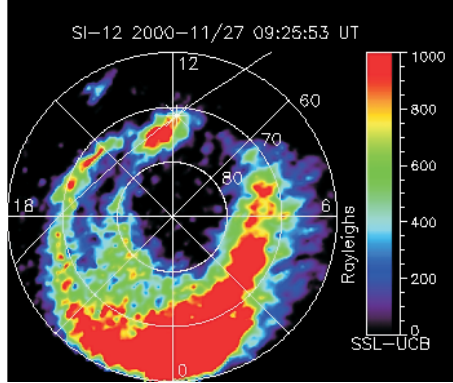
Fig. 10. As for Fig. 9 at 09:25:53 UT.